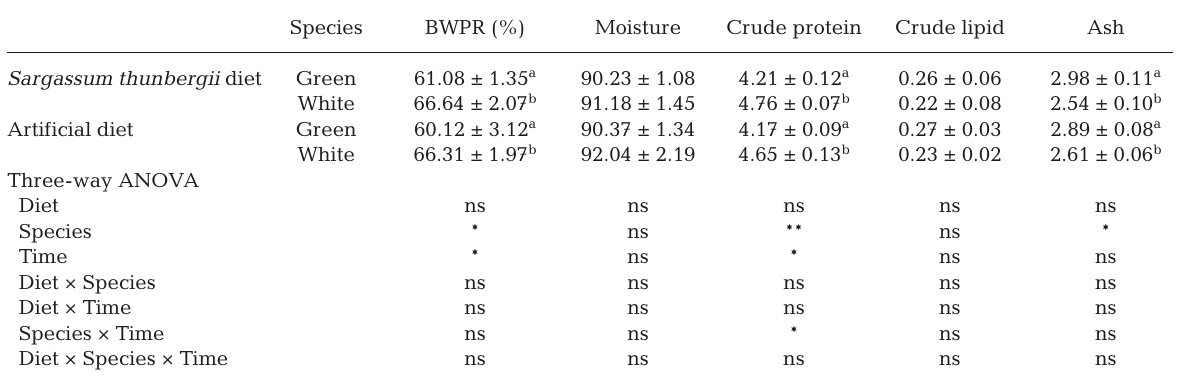
diets with higher nitrogen stable isotope ratios. (p < 0.05). The turnover rates in the intestine of sea There were significant shifts between the sampling cucumber fed S. thunbergii and artificial diet ( T 14.98 to 34.25 d) were faster than that of the body time points (p < 0.05). Significant differentiations in = 29.66 to 60.80 d). wall ( T the nitrogen stable isotope signatures between green 0.5 and white sea cucumber also commenced from the first week. Green sea cucumber had shorter half- = 14.98 to 15.23 d; for body lives (for intestine, T 0.5 = 29.66 to 33.68 d) compared to white sea wall, T 0.5 = 25.77 to 34.25 d; for cucumber (for intestine, T 0.5 = 51.73 to 60.80 d) according to the body wall, T 0.5 calculations of the time-based turnover model (Table 4). Sea cucumbers fed S. thunbergii showed shorter half-lives than those fed the artificial diet, except for the intestine of green sea cucumber, and the half-lives were significantly affected by the inter- action of diet and species for intestine and body wall